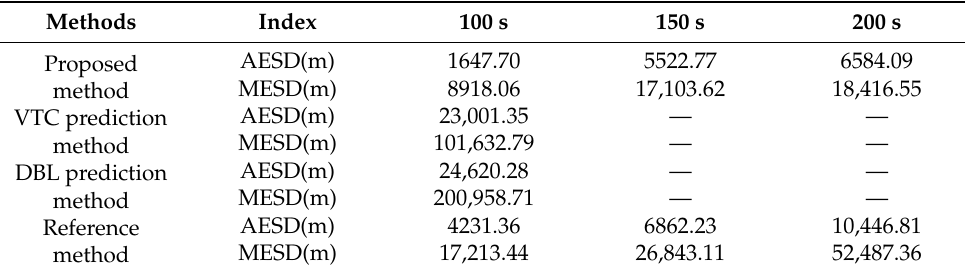
Table 2. Prediction error between different prediction.